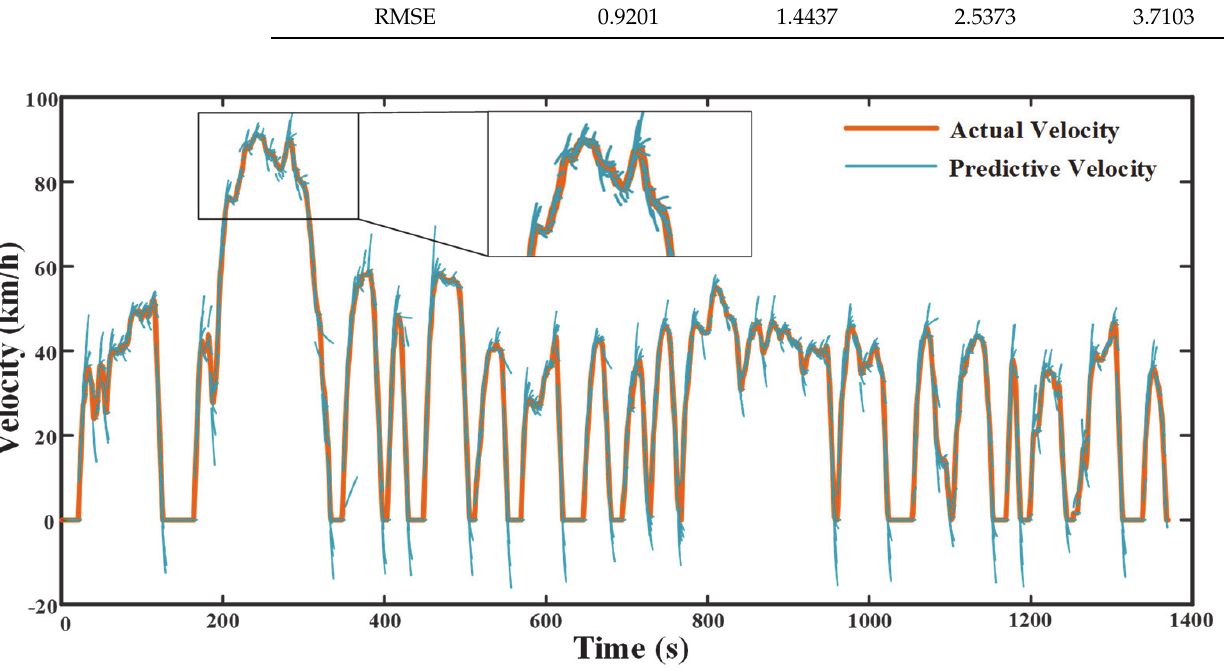
Figure 12. Prediction performance of exponential predictor at 5 s prediction step.